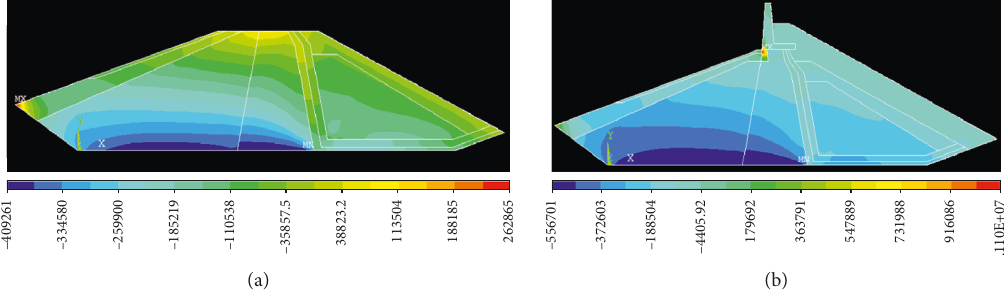
Figure 12: Contour of the maximum principal stresses of the dam foundation and earthfill embankment: (a) initial section and (b) final section.